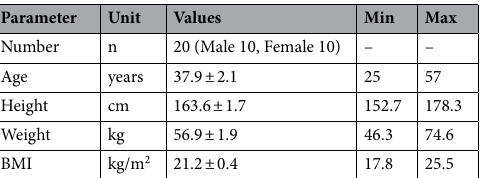
Table 1. Characteristics of the participants. Values are presented as mean ± SE. BMI body mass index, SE standard error.